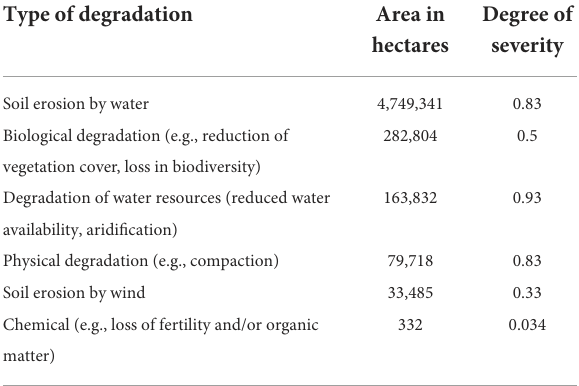
TABLE 1 Area and degree of severity per type of degradation within Souss-Massa